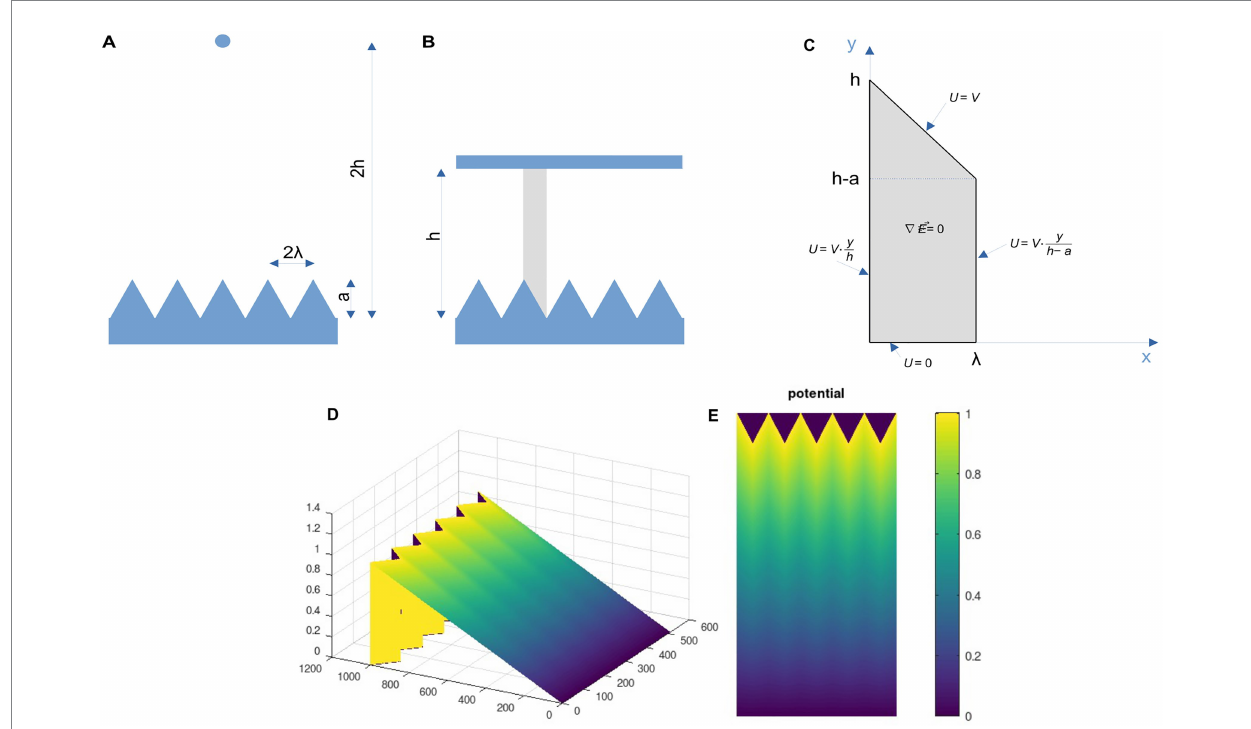
FIGURE 10 (A) and (B) Geometry of the field problem. The original problem (A) with a point source at the distance 2 h is converted to the approximated problem (B) with an infinite plate at the distance h . If the solution of the field problem in the gray area in (B) can be obtained, this solution can be mirrored at the vertical boarders of this area and thus the whole problem can be solved. (C) Field problem of one elementary cell. For the gray area the Laplace equation must be solved for the boundary conditions given. (D) and (E) Approximation of the potential distribution in the cleft between the triangular surface and a grounded plate. The results are shown for V = 1 and height h = 10 a . The opposite polarization (grounded triangular structure and charged plate) can be explained by the linearity of the field problem in addition to a constant additional factor and a sign